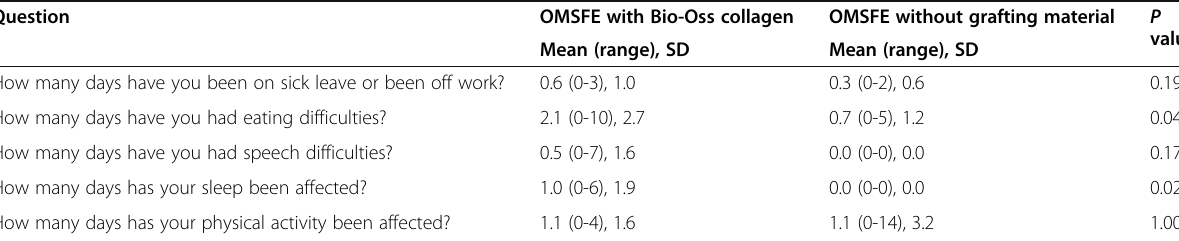
Table 6 Questionnaire assessing days of recovery at 1